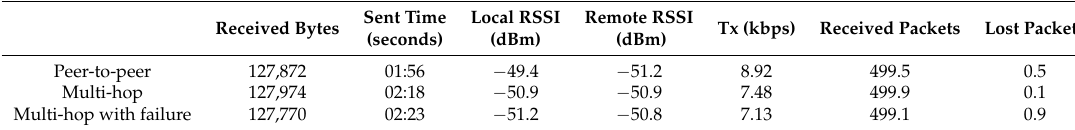
Table 10. Results obtained in scenario 2.